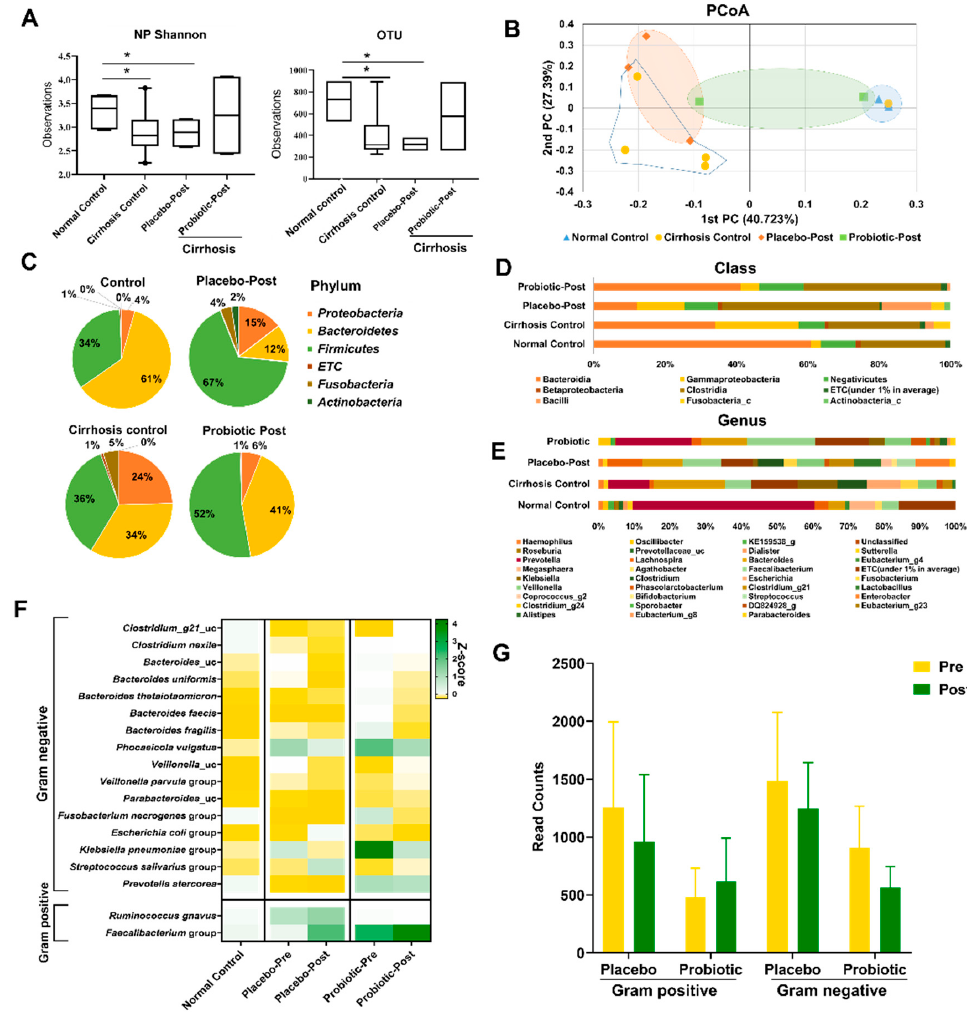
Figure 4. Taxonomic profiles. ( A ) Alpha diversity. Boxplot for alpha diversity representing the mean species diversity in placebo and probiotic treated groups compared with normal and cirrhotic con- trol. ( B ) Principal coordinate analysis plot for beta diversity generated from generalized unifrac for genus. Microbial composition of placebo and probiotic treated groups compared with normal con- trol and cirrhosis control at ( C ) phylum level, ( D ) class level, and ( E ) genus level. ( F ) Heatmap show- ing changes in species level before and after treatment. ( G ) Change of strains according to Gram’s classification. Data are presented as mean ± standard error of the mean. * represents significant value, p < 0.05. PC, principal coordinate; PCoA, principal coordinate analysis; OTU, operational tax- onomic unit.